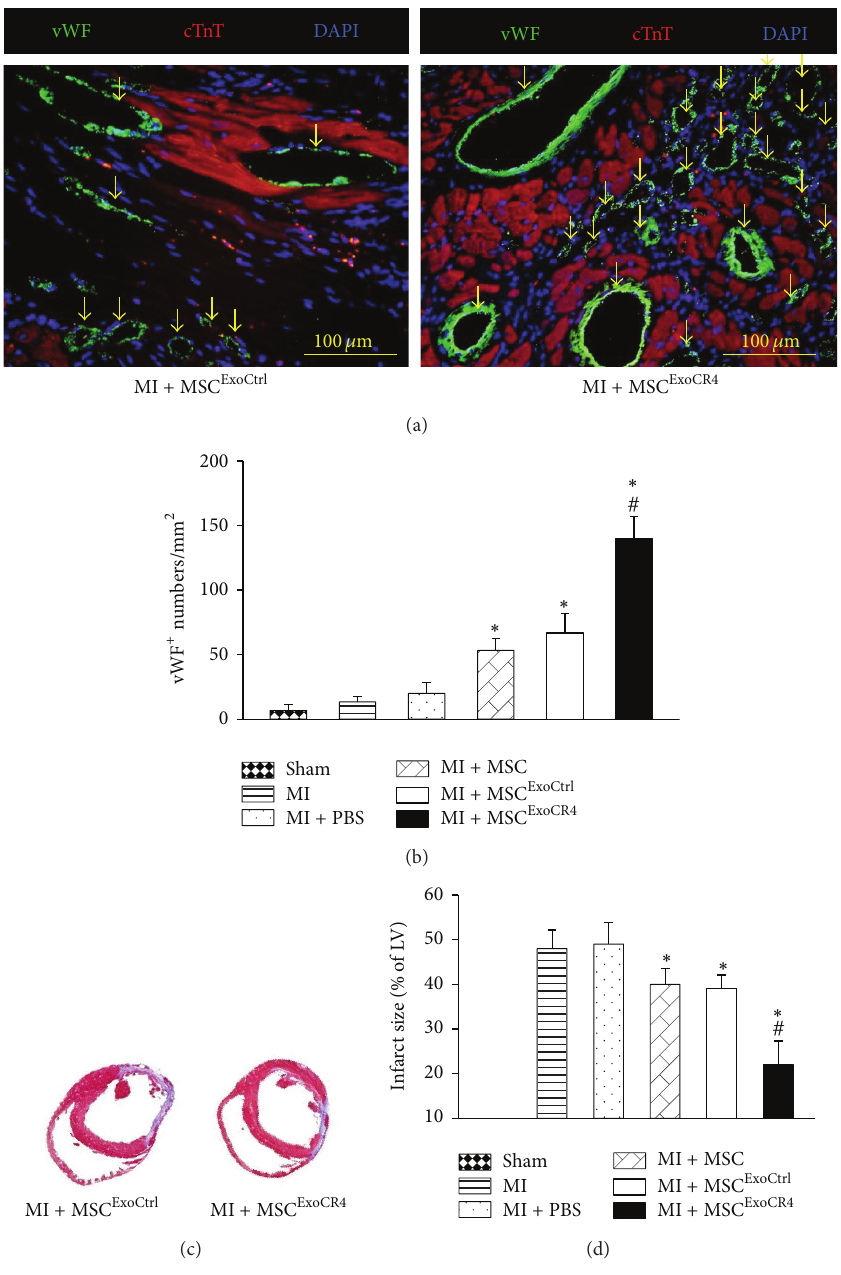
Figure 6: Effects of exosome pretreated MSC patch on in vivo angiogenesis in infarcted myocardium. (a) The vessel formation in the infarcted border area was identified by vWF (green color, yellow arrows). Cardiomyocytes were identified by cardiac troponin T (cTnT) and all nuclei were stained with DAPI. Scale bar = 100 𝜇 m. Original magnification × 400. (b) Quantitative data for vessel density in treatment groups. ∗ 𝑃 < 0.05 versus MI group; # 𝑃 < 0.05 versus MI + MSC ExoCtrl group. (c) Masson’s trichrome staining and quantitative data for fibrotic size in various treatments. (d) The percentage of infarct size in hearts of various groups. ∗ 𝑃 < 0.05 versus MI; # 𝑃 < 0.05 versus MI + MSC ExoCtrl group. Sham: sham operated rats had a loose suture placed around the LAD coronary artery; MI (myocardial infarction alone created by LAD ligation); MI + PBS (MI + PBS alone treatment); MI + MSC (MI + MSC transplantation); MI + MSC ExoCtrl (MI + Exo Ctrl pretreated MSC transplantation); MI + MSC ExosiCR 4 (MI + Exo siCR 4 pretreated MSC); MI + MSC ExoCR 4 (MI + Exo CR 4 pretreated MSC). ∗ 𝑃 < 0.05 versus MI; # 𝑃 < 0.05 versus MI + MSC. All values expressed as mean ± SEM, 𝑛 = 6 for each